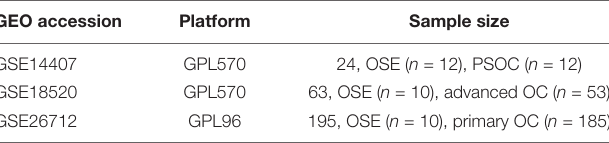
TABLE 1 | The information about the GEO datasets analyzed in this